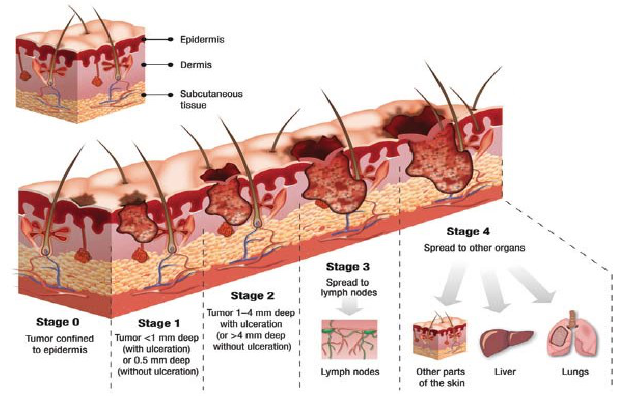
Figure 1: Skin cancer stages (source: